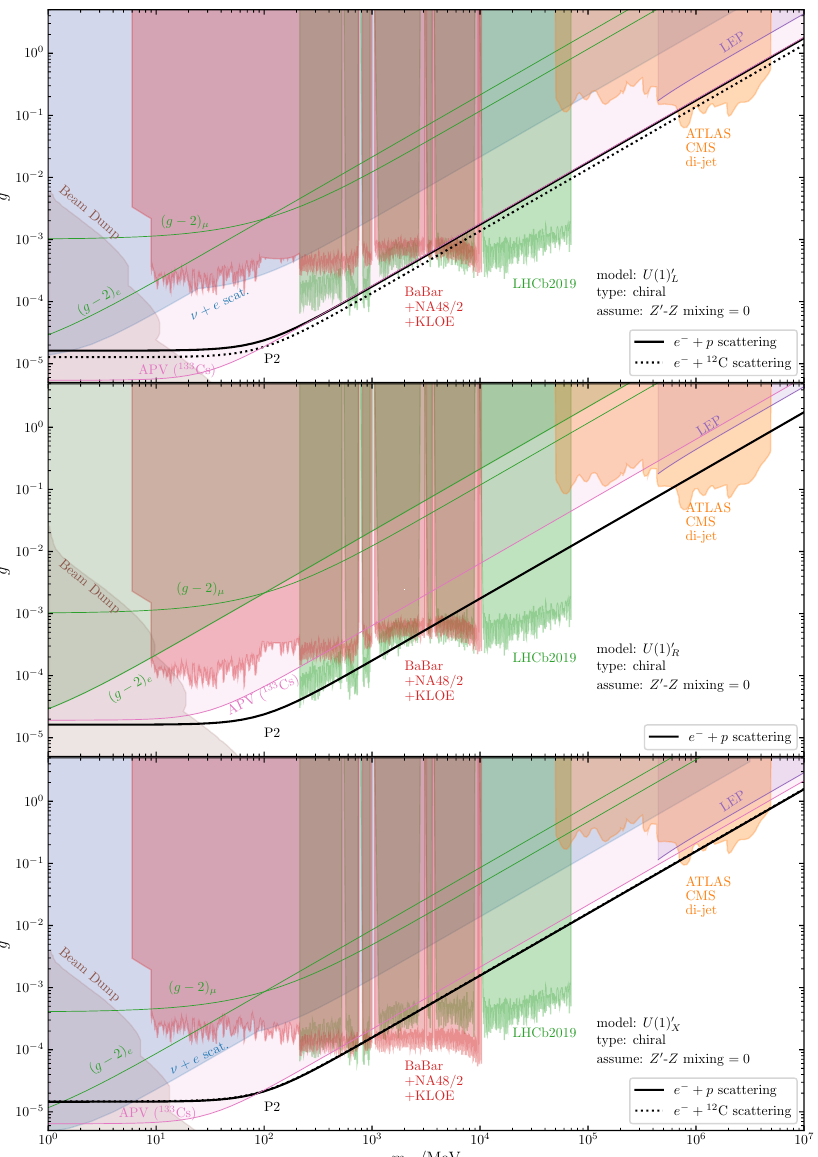
Figure 2 . Sensitivities of the P2 experiment in e + p (solid black) and e + 12 C (dashed black) scatterings to the gauge coupling g 0 in three chiral U(1) 0 models given in table 2. For simplicity we have assumed here that there is no mass or kinetic Z - Z 0 mixing. The shaded regions are excluded by APV measurements [24–27], beam-dump experiments [74–77], electron and muon g − 2 [1, 102], BaBar [79, 80], NA48/2 [81], KLOE [82], LHCb [84], LEP e + e − → ‘ + ‘ − data [89] and the ATLAS and CMS dijet data [90]. Note that, due to the cancellation of quantum numbers in eq. (3.5), the P2 prospect in the e + 12 C channel is absent for the U(1) 0 model (middle panel). See sections 4.2 R and 4.3 for more